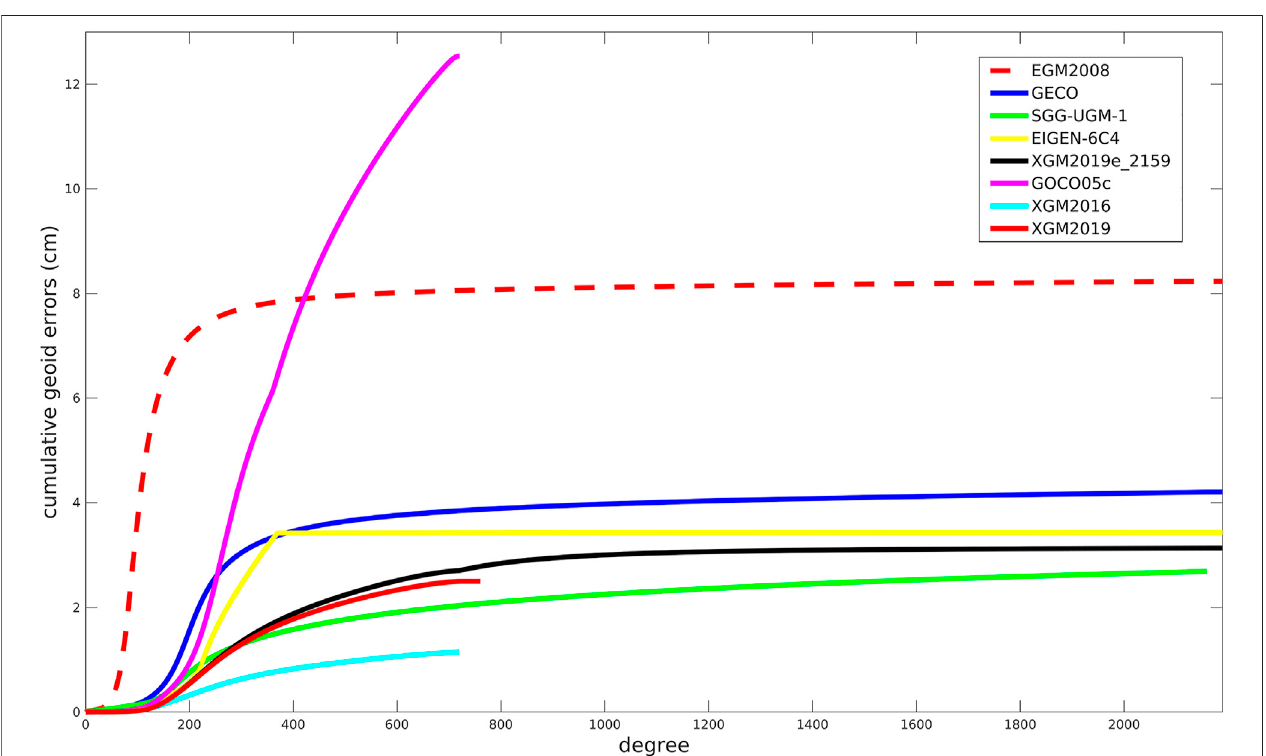
FIGURE 2 | Cumulative geoid errors of different GGMs as a function of spherical expansion